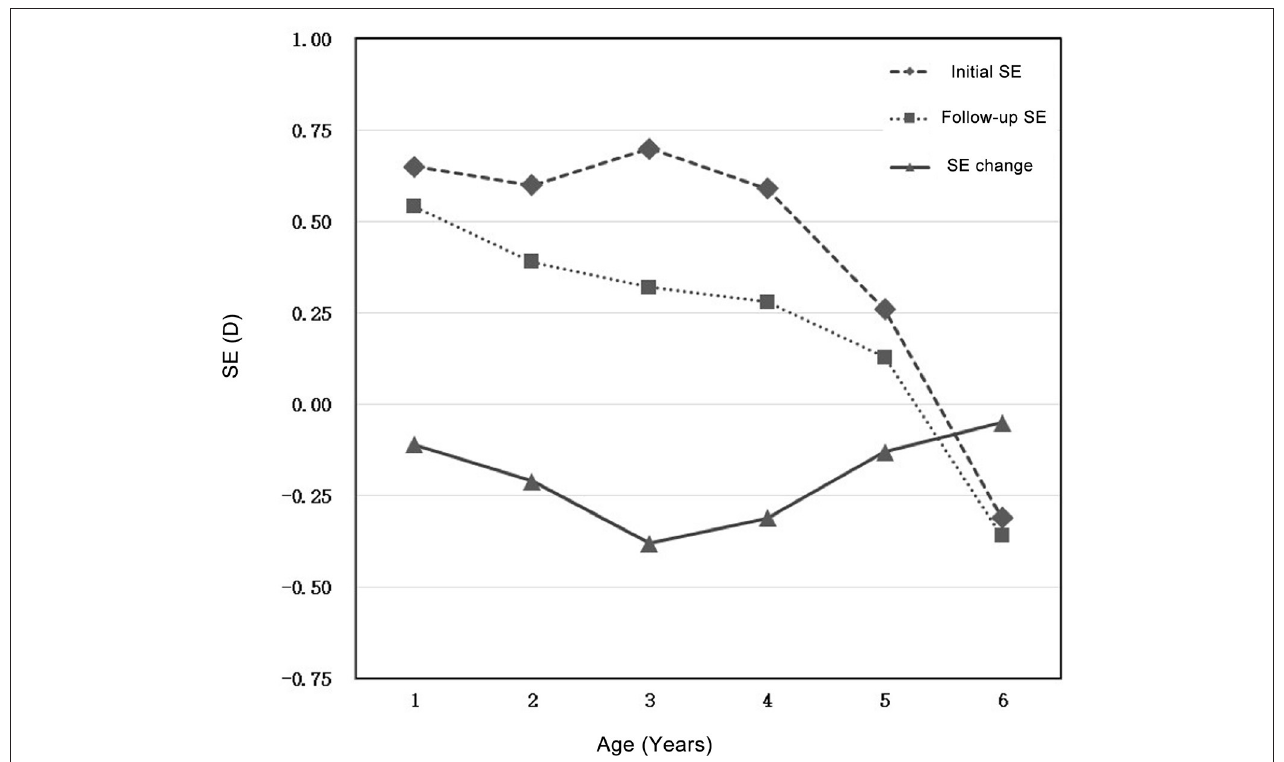
FIGURE 1 | Initial SE, follow-up SE, and SE change for preschool children aged 1–6